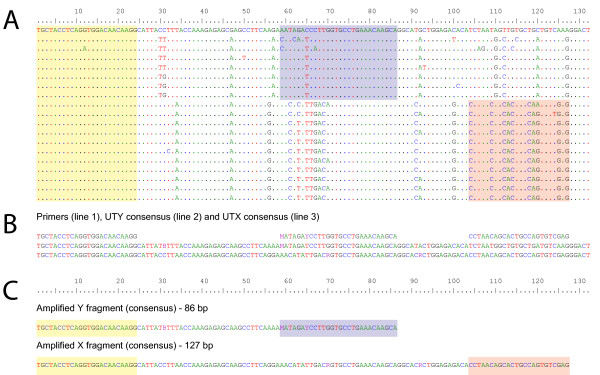
UTY/UTX alignment.A) Alignment of primate UTX/UTY regions. B) Top: Primers. Middle: UTY consensus sequence. Bottom: UTX consensus sequence. C) The resulting consensus fragments amplified by the three primers.